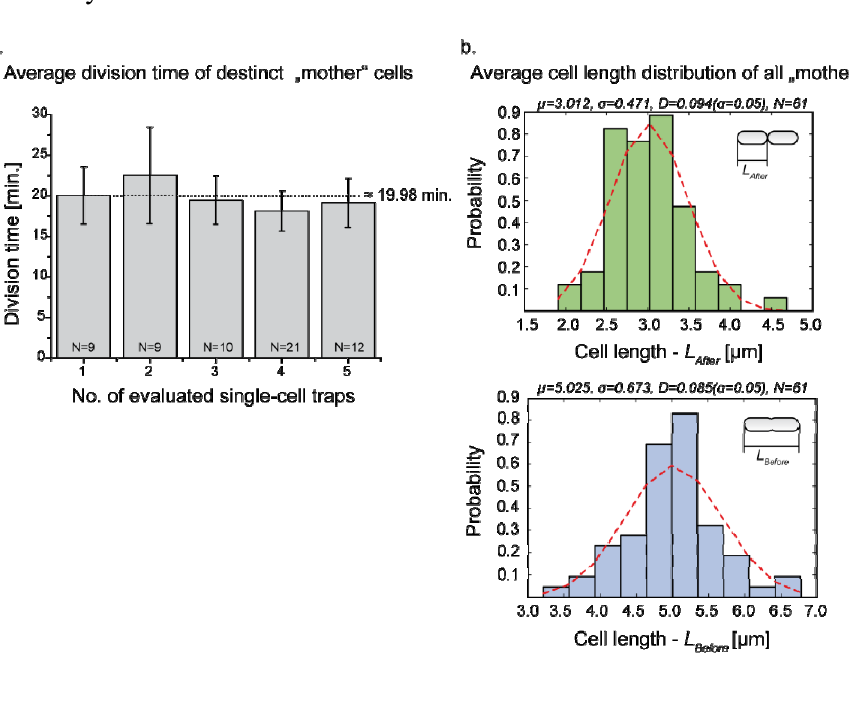
Figure 6. ( a ) Average division time of 20 min derived from 5 single-cell trapping structures over the whole cultivation period of 300 min. ( b ) Average cell length ≈ 5 µm) and after ( L ≈ 3 µm) division of all analyzed traps, distribution before ( L Before After showing a nearly Gaussian